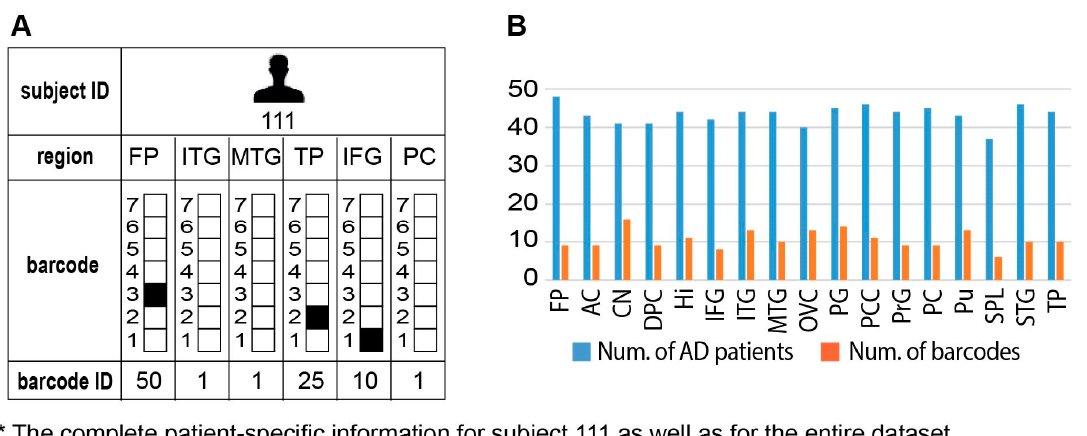
Figure 6. Intra-brain heterogeneity: different brain regions in the same subject can be characterized by distinct barcodes. ( A ) Subject 111 was selected to exemplify this point: four distinct barcodes were found to characterize six different brain regions in this subject. The complete information for subject 111 as well as for the entire dataset can be found in Table S4. ( B ) In general, we found that every brain region was characterized by several distinct barcodes of unbalanced processes. The complete and detailed information can be found in Table S4.